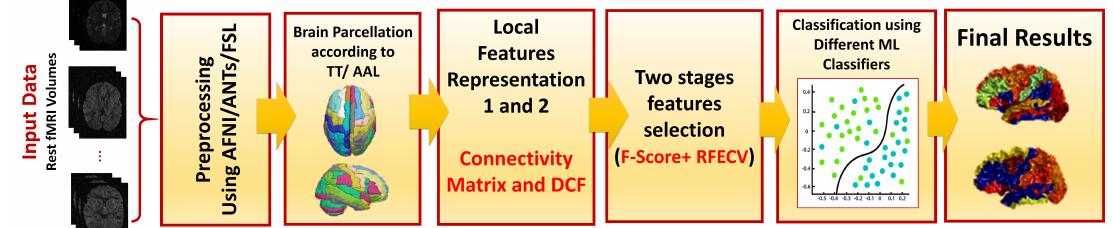
Figure 1. Illustration of the full steps of the adopted framework, including preprocessing, brain parcellation, feature representation, feature selection, and machine learning (ML)